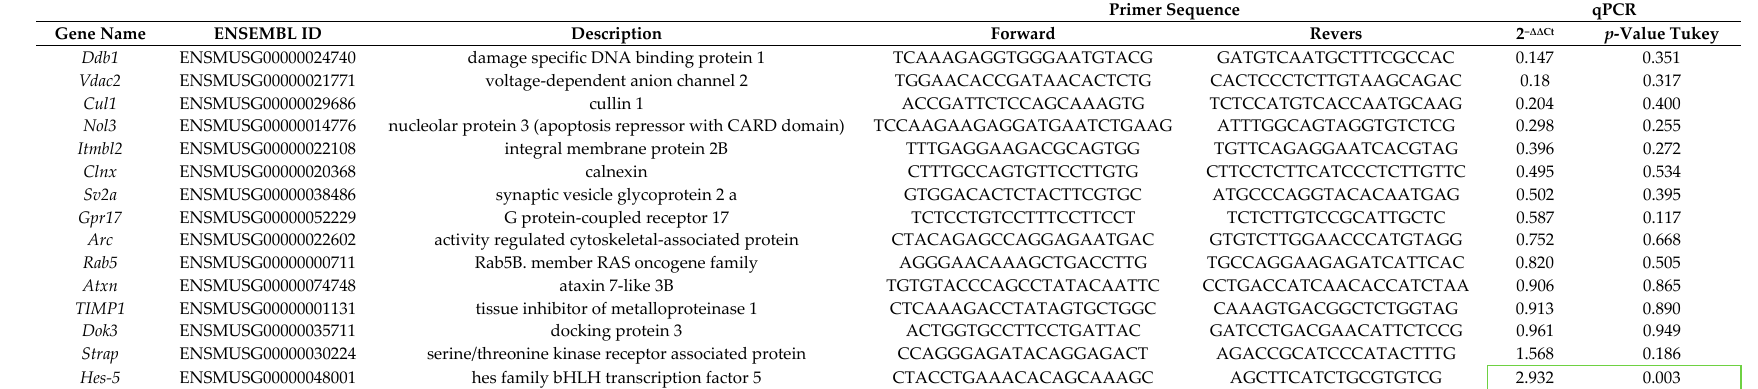
Table 2. List of selected genes together with primers sequence whose expression profile was analyzed using real-time PCR. Up-regulation of hairy and enhancer of split-5 ( Hes-5) , a transcriptional repressor, was detected in the hippocampus of Tg(ORA1)Ibd line (highlighted in green).